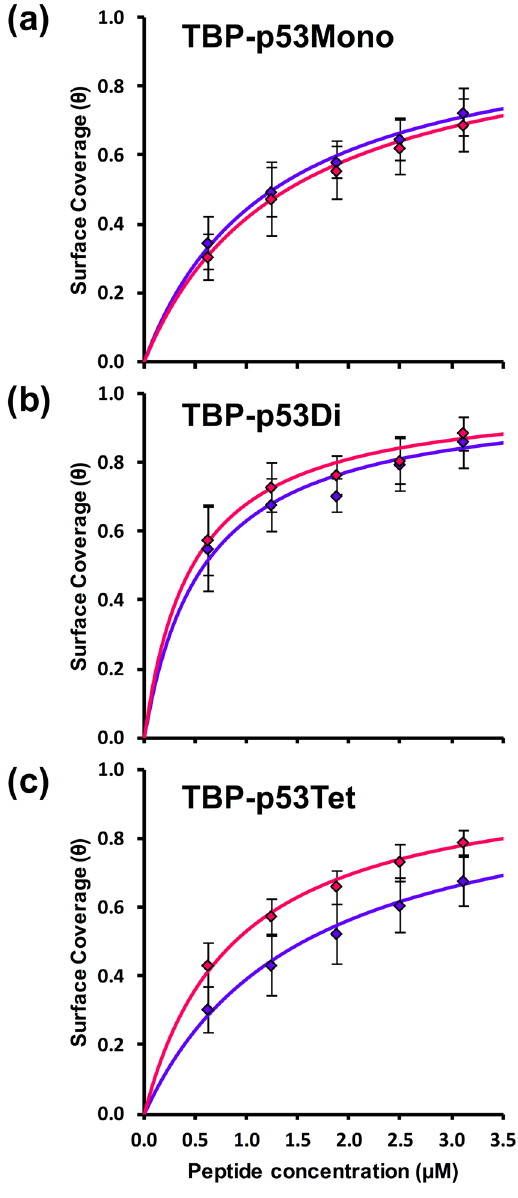
Figure 2. Plot of the surface coverage against peptide concentration of ( a ) TBP ‒ p53Mono, ( b ) TBP ‒ p53Di and ( c ) TBP ‒ p53Tet. The markers indicate observed surface coverage for nanoparticles (blue) and nanostructures (red). The lines indicate calculated surface coverage for nanoparticles (blue) and nanostructures (red). The error bars of each plot are standard